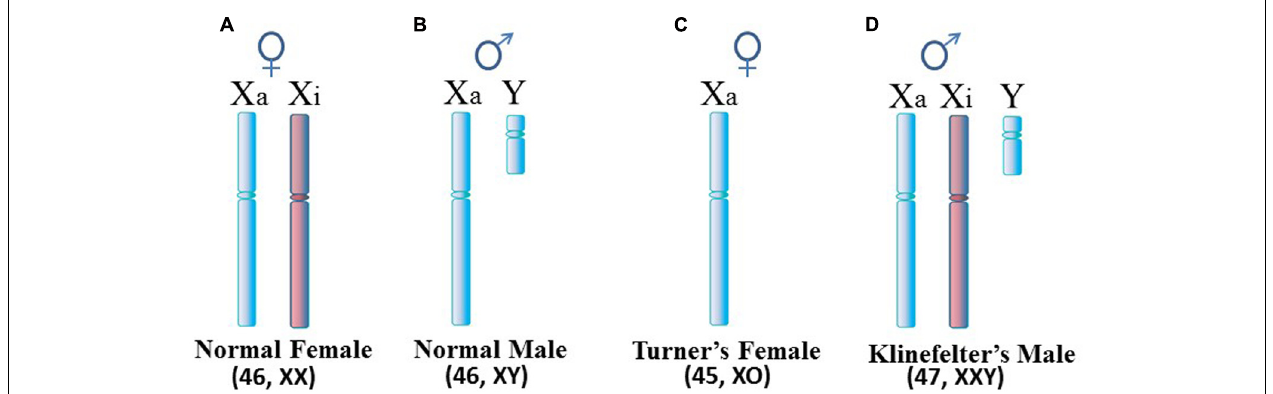
extra X which is usually inactivated. For X inactivation to occur, it requires at least two X inactivation centers (XICs) in close proximity so that a stoichiometric-triggered random selection can be made as to which X to inactivate, the maternally derived X or paternally derived X. Each daughter cell will maintain inactivation of the same parentally derived X